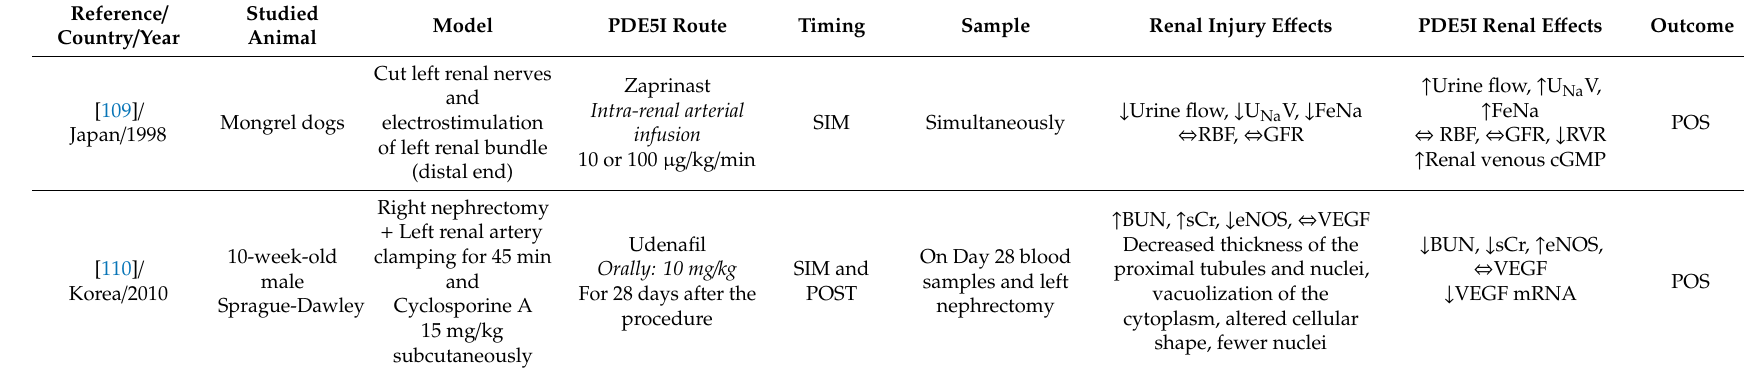
Table A5. Animal studies evaluating the potential reno-protective e ff ects of zaprinast and